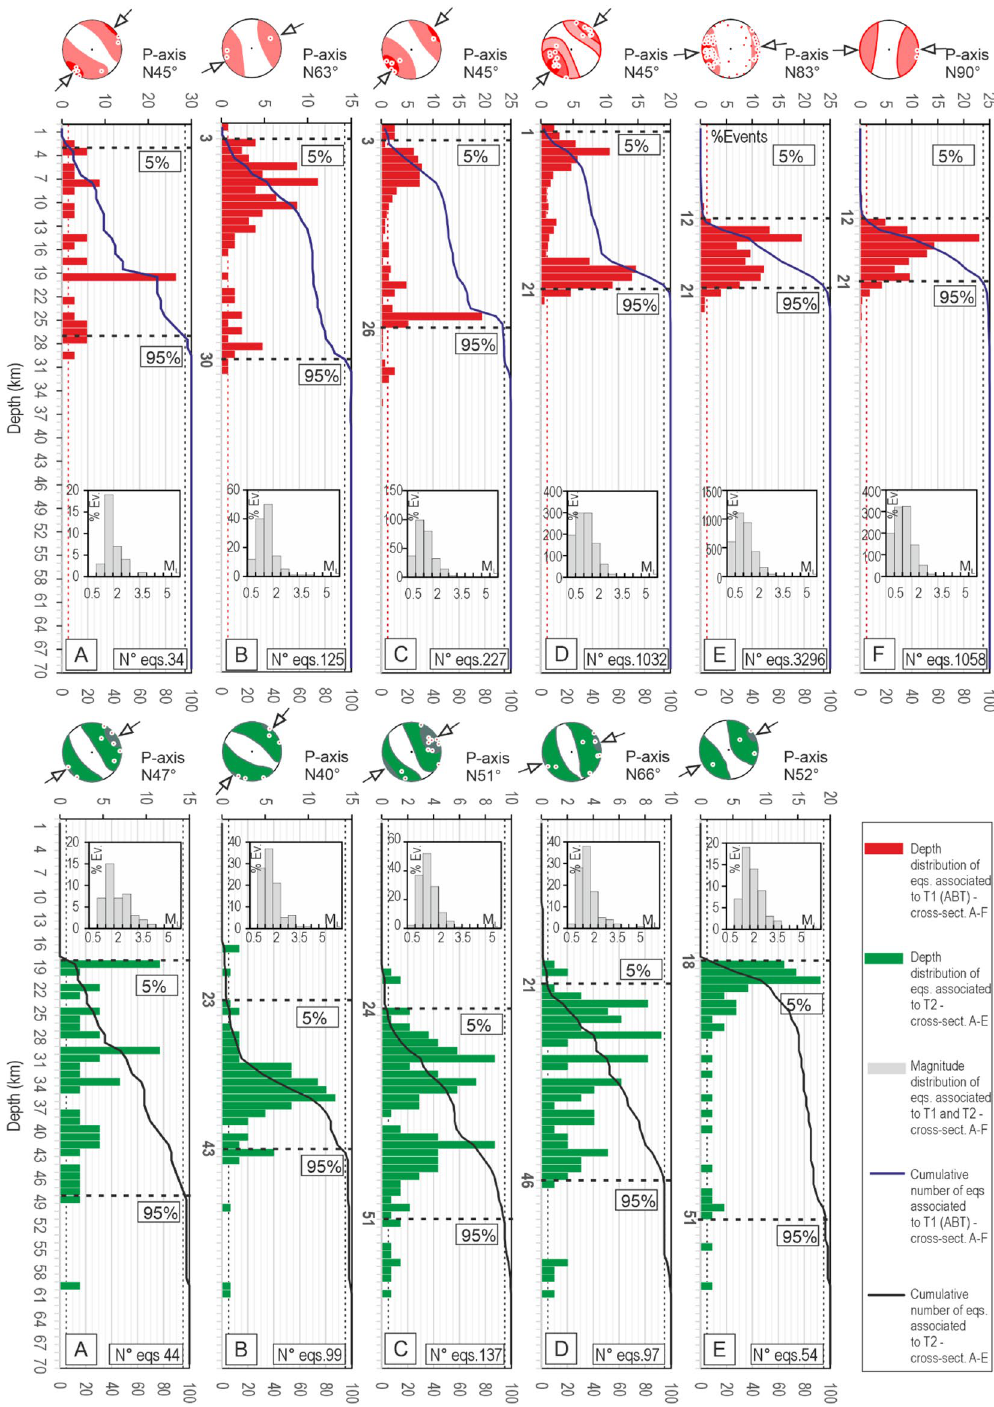
Figure 4. Depth distribution of events associated with T1 (red histograms) and T2 (green histograms) along the six transects (A–F) in Fig. 3c; in each histogram, the black horizontal dashed lines identify the top and bottom of the seismogenic layer assumed to correspond to 5% and 95% of the hypocentral distribution, respectively. The small grey histograms represent the magnitude distribution of events within each transect. The stereoplots represent the density contour of the P-axes (white circles) of the focal mechanisms falling within each